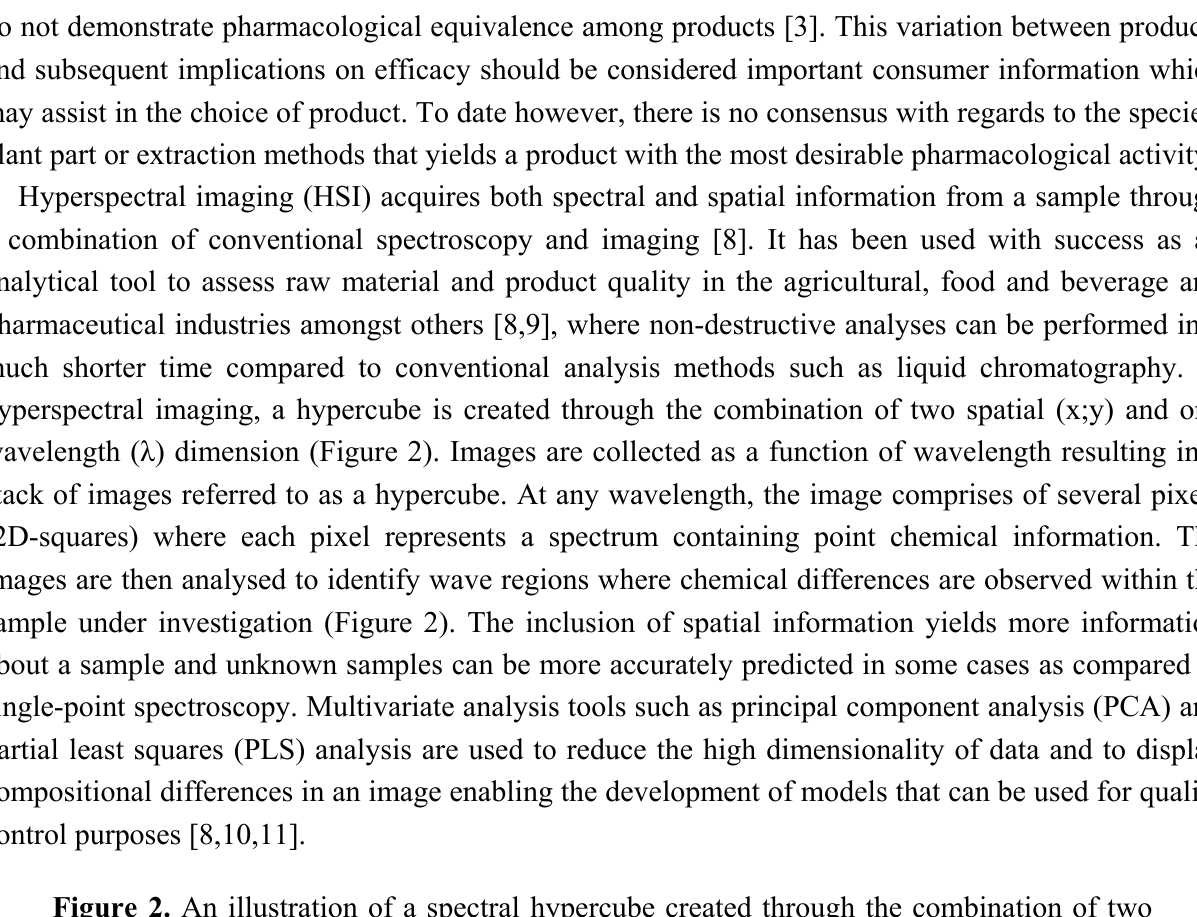
Figure 2. An illustration of a spectral hypercube created through the combination of two spatial (x;y) and one wavelength ( λ ) dimension in hyperspectral